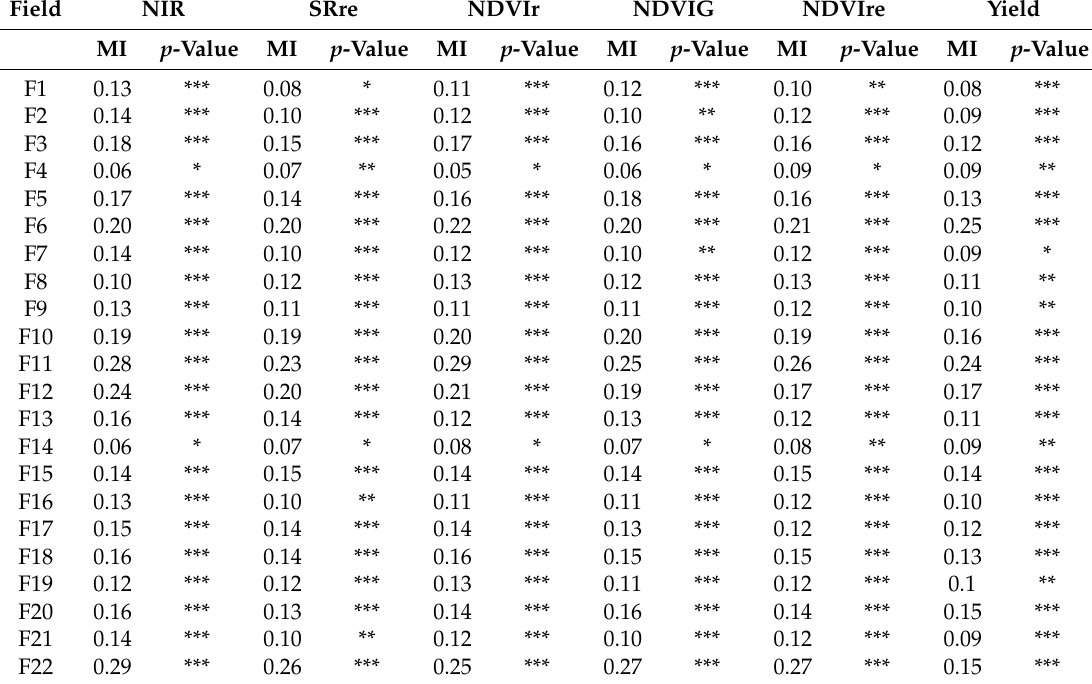
Table 3. Moran’s I test (MI) to vegetation indices (VIs) obtained from mid-season high-resolution satellite imagery and yield monitor